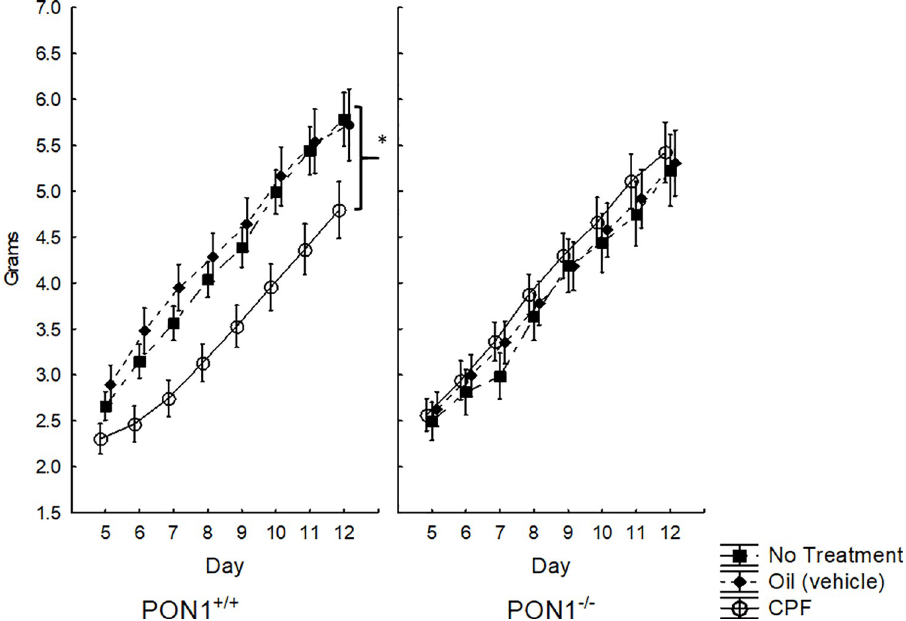
Fig 2. Mean + SEM body weight in grams for mouse pups, showing the significant interaction between Genotype and CPF. PON1 +/+ , but not PON1 -/- mice, exposed to CPF had lower body weight. � CPF vs vehicle (p < .001), CPF vs NT (p < .03). Number of animals per group as follows: B6-NT n = 9, B6-Vehicle n = 5, B6-CPF n = 8. PON1 -/— NT n = 5, PON1-/-—Vehicle n = 6, PON1-/-—CPF n = 7.